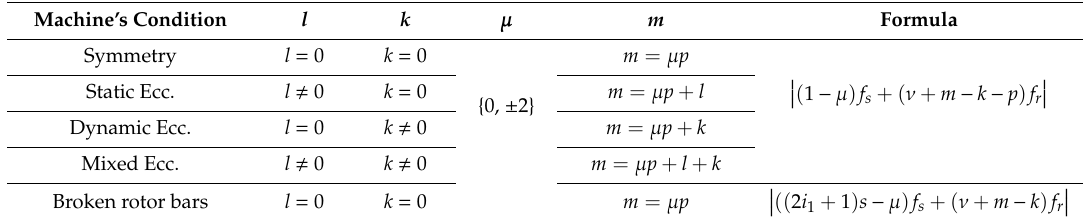
Algorithm of Characteristic Frequencies Calculation for a Given Type of Asymmetry